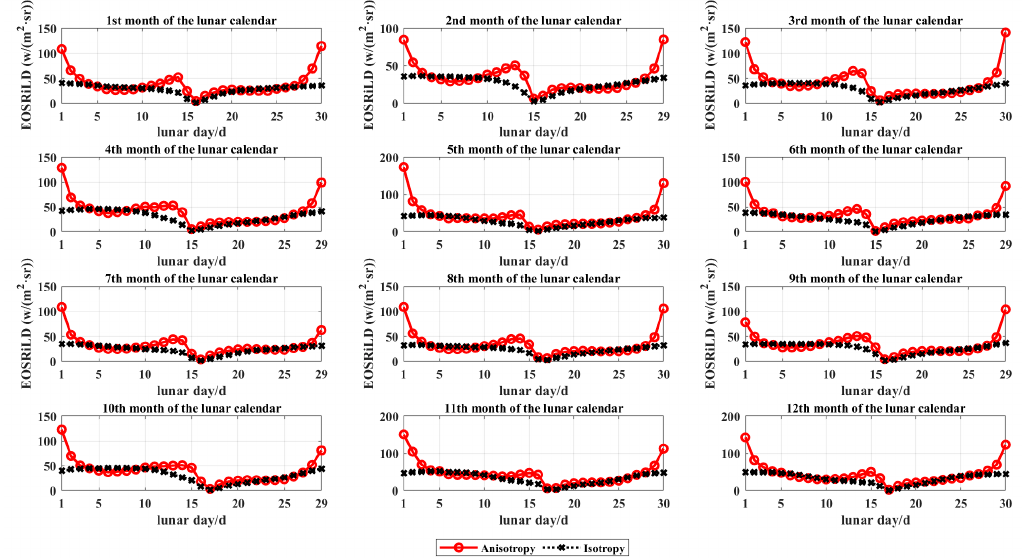
Figure 11. Twelve lunar month simulation of daily EOSRiLD from 5 February 2019 to 24 January 2020 based on the lunar calendar.